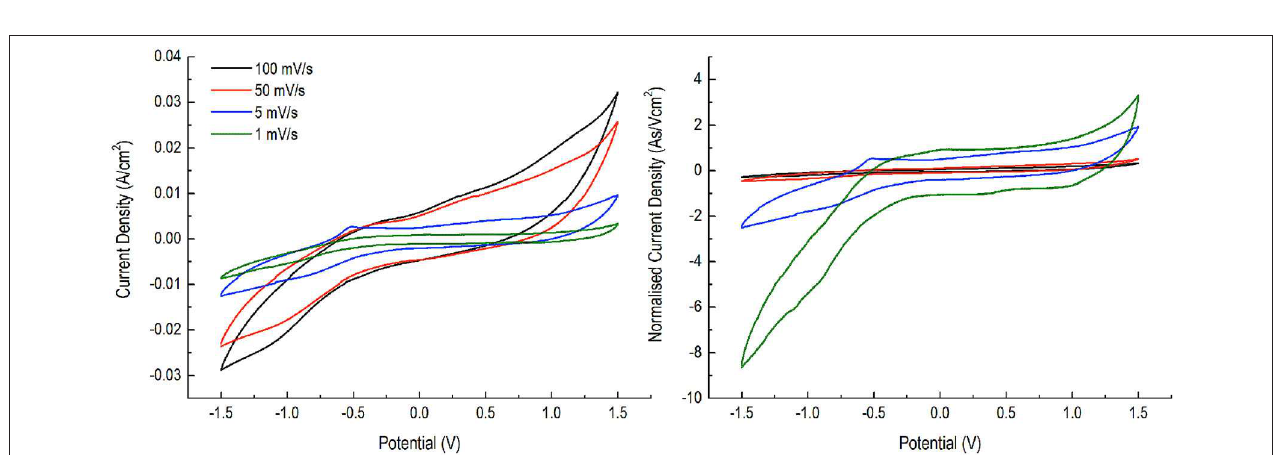
FIGURE 4 | Electrochemical characterization of all the composites. CV was performed in the voltage range of − 1.5V to + 1.5V at a scan rate of 5 millivolt (mV) per second. Charge discharge analyses (CC/CC mode) were performed using a constant charging and discharging current of 5 milliampere (mA) in the voltage range of − 1.5V to + 1.5V. (A) Cyclic voltammogram analysis. (B) Sulfur spillage in NDRGO-Li-4S composite. (C) Charge-discharge analysis.